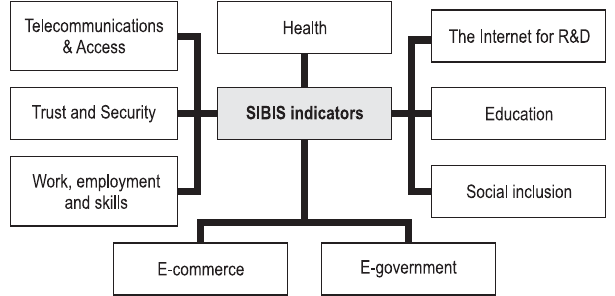
Fig. 6. Statistical indicators benchmarking the information society’s (SIBIS) classifi cation of